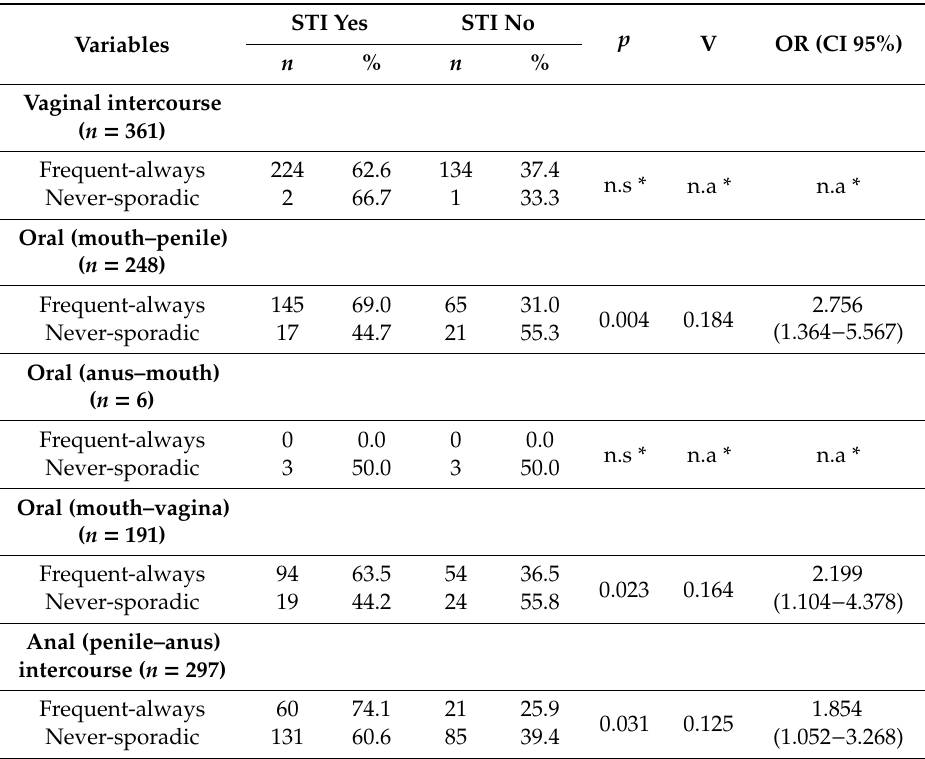
Table 3. Sexual habits and STI